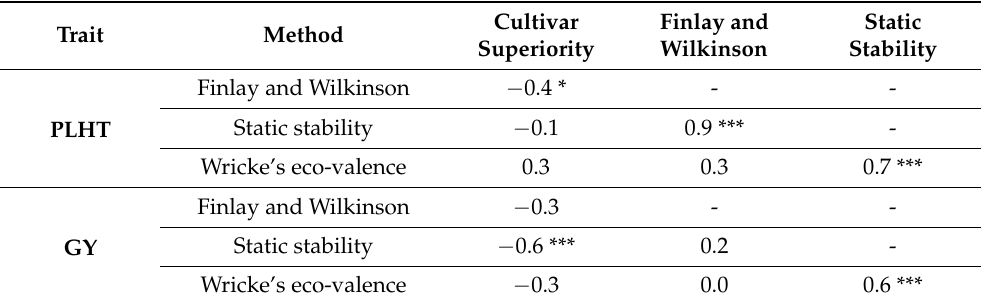
Table 5. Correlation coefficients between the stability parameters of the 37 faba bean accessions tested across 12 environments. Cultivar Finlay and Static Trait Method Superiority Wilkinson Stability Finlay and Wilkinson − 0.4 * - - Static stability − 0.1 0.9 *** - PLHT Wricke’s eco-valence 0.3 0.3 0.7 *** Finlay and Wilkinson − 0.3 - - Static stability − 0.6 *** 0.2 - GY Wricke’s eco-valence − 0.3 0.0 0.6